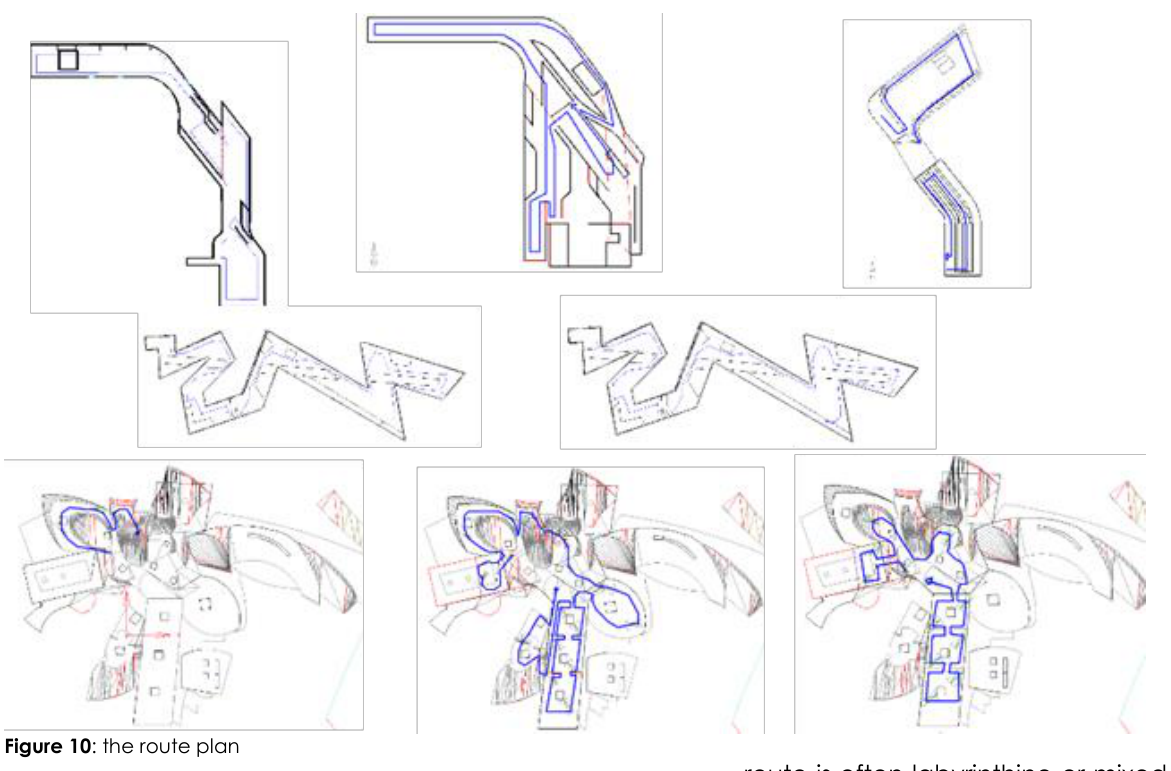
Figure 10 : the route